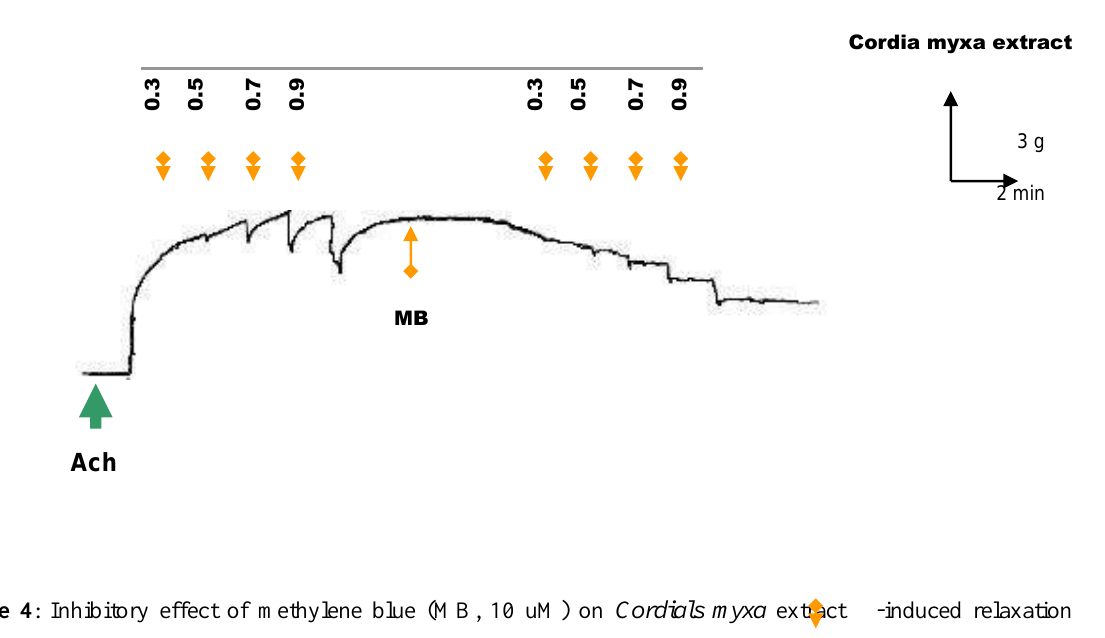
Figure 4 : Inhibitory effect of methylene blue (MB, 10 uM) on Cordials myxa extract -induced relaxation of tracheal sheep.